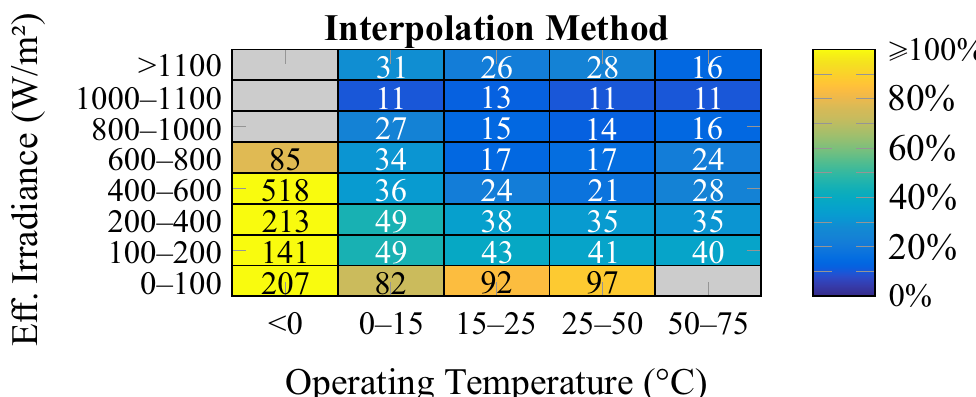
Figure 7. RMSE values (%) calculated from the results obtained by the interpolation method recom- mended by IEC 61853-3 for the different range of operating conditions verified for the PV modules under